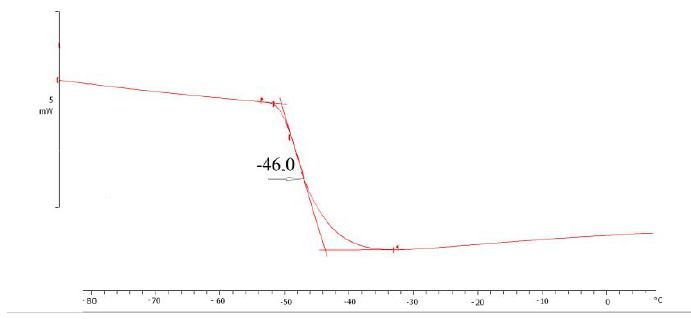
Figure 9. DSC thermogram of PVC composition containing DPEA.